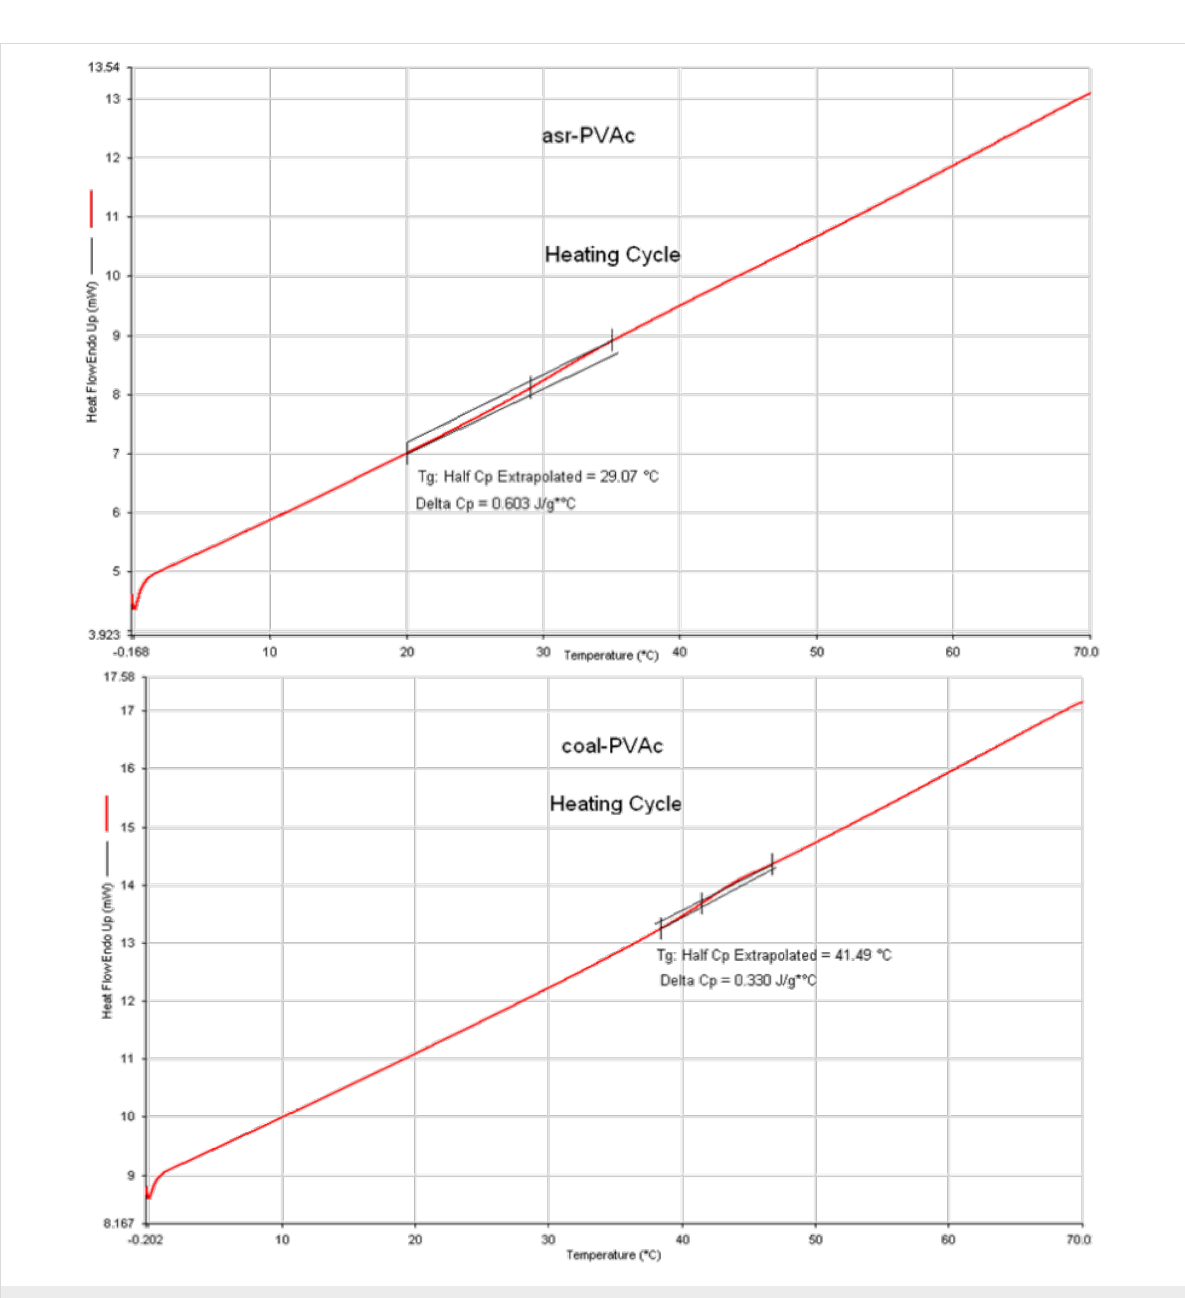
then the host α -CD was stripped away to yield bulk coalesced PCL (c-PCL), a process referred to as coalescence [65]. The thermal, physical, and melt rheological properties of c-PCL resulting from this coalescence process were observed to be im- proved, as a result of the largely extended, unentangled coalesced PCL chains. This also resulted in substantial increases in melt-crystallization temperatures, T c ’s (up to 25 °C higher, depending on the cooling rate from the melt), as illus- trated in Figure 5, even though PCL is ordinarily an inherently “fast melt-crystallizer”. Similarly enhanced crystallizabilities